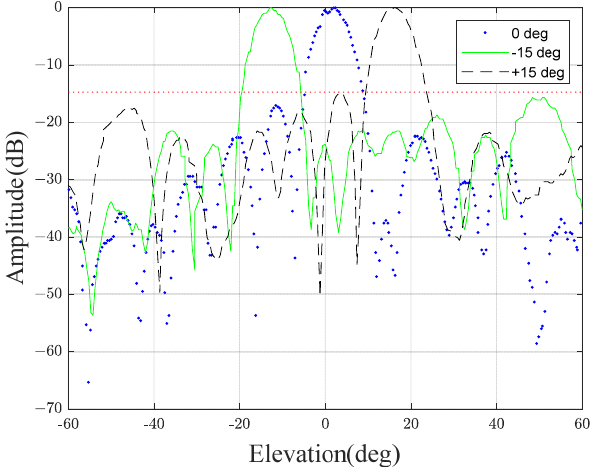
Figure 12. The measured patterns in the elevation direction.